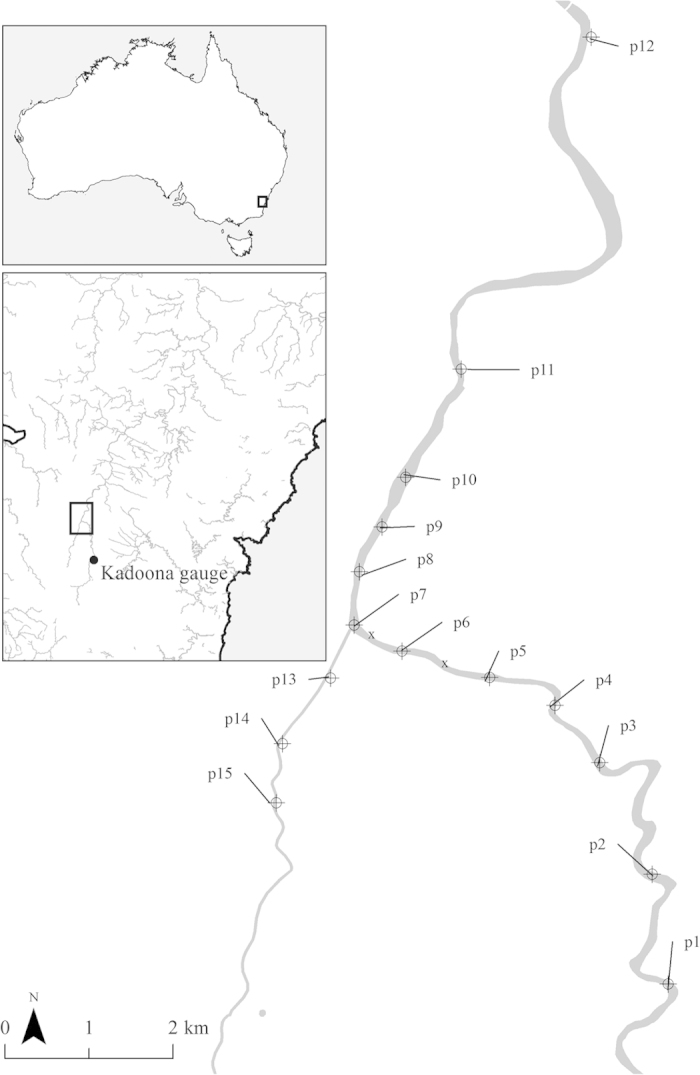
Location of the extant 15 pools (p) in the Shoalhaven River (1–12) and Jerrabattgulla Creek (13–15) (shaded) and two filled-in pools (x) in south-eastern Australia (insets), where platypus were captured and marked, 1973–2014.River flow was measured at the Kadoona flow gauge. Figure was generated using ArcGIS 10.395.